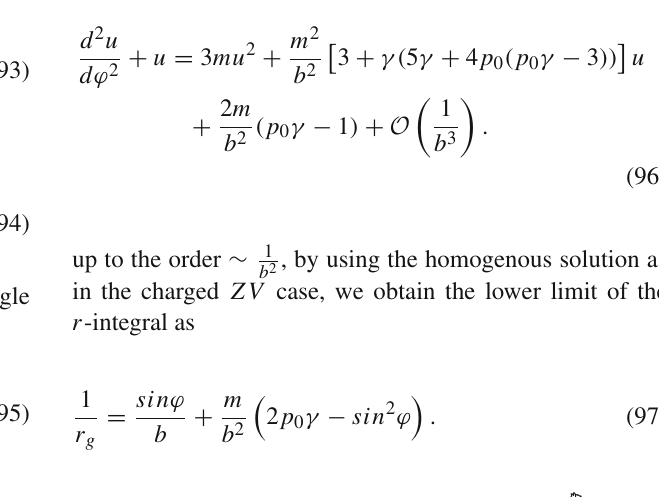
l (0 < l < ∞ ), p 0 is strongly bounded, i.e. p 0 ≤ 1 .